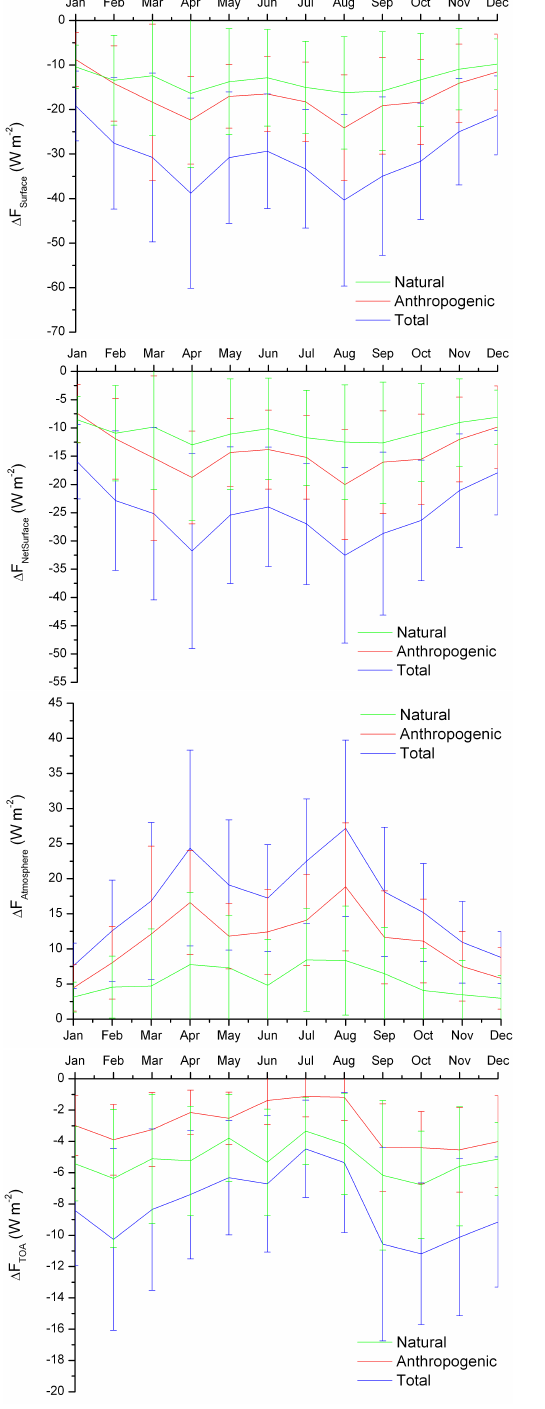
Fig. 12. Mean monthly aerosol DRE and its components (anthro- pogenic and natural) with standard deviations for the period 2000– 2010 (a) incident at the surface (HCMR Station), (b) absorbed by the surface, (c) in the atmosphere and (d) at TOA, derived using Terra MODIS data.